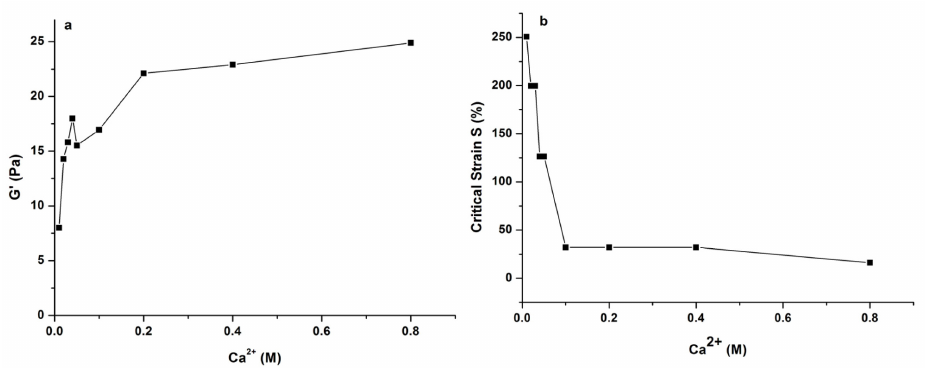
Figure 7. Variation of elastic modulus (G (cid:48) ) ( a ) and critical strain (S) ( b ) of 1.0% PLAP added with 0.2 M Ca 2+